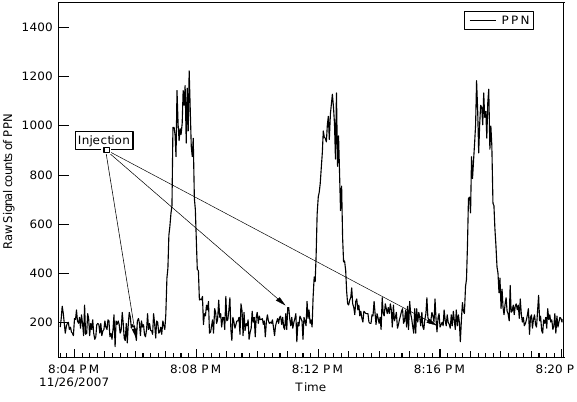
Fig. 8. Time sequence of the m/e=73 signal observed by TD-CIMS when the diffusive PPN source was coupled into the inlet through the prep-GC. No interference from propionic acid was